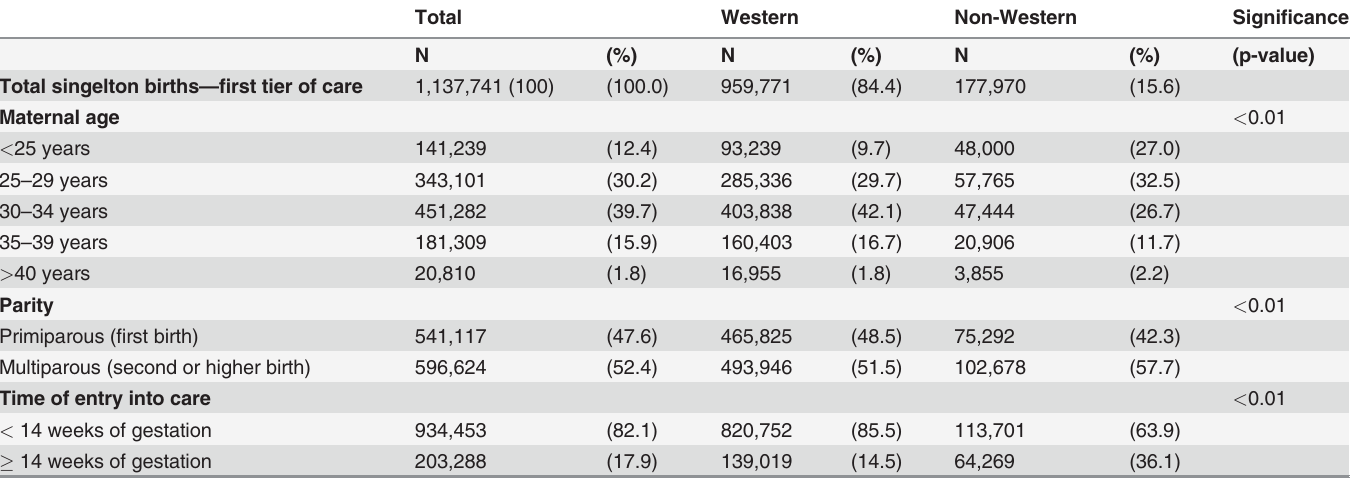
Table 2. Descriptive statistics of individual variables and time of entry into